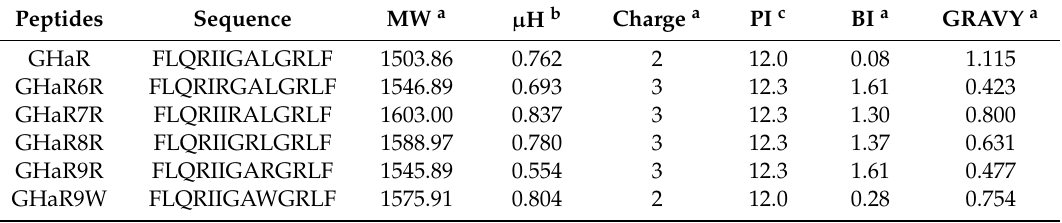
Table 1. Amino acid sequences and physicochemical properties of GHaR and the derived peptides. Peptides Sequence MW a GHaR GHaR6R FLQRIRGALGRLF 1546.89 0.693